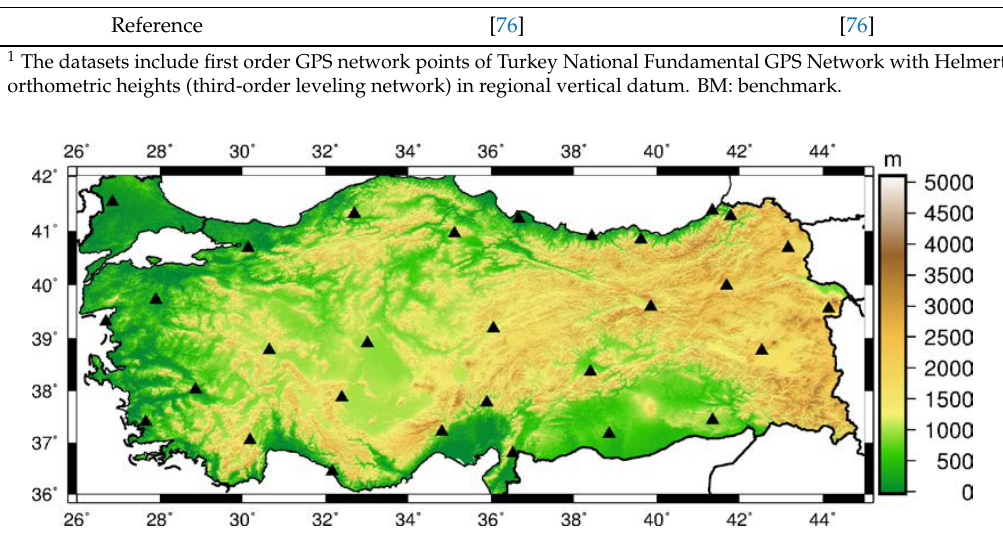
Figure 2. Distribution of 30 benchmarks (Dataset I) on Shuttle Radar Topography Mission (SRTM) topography.